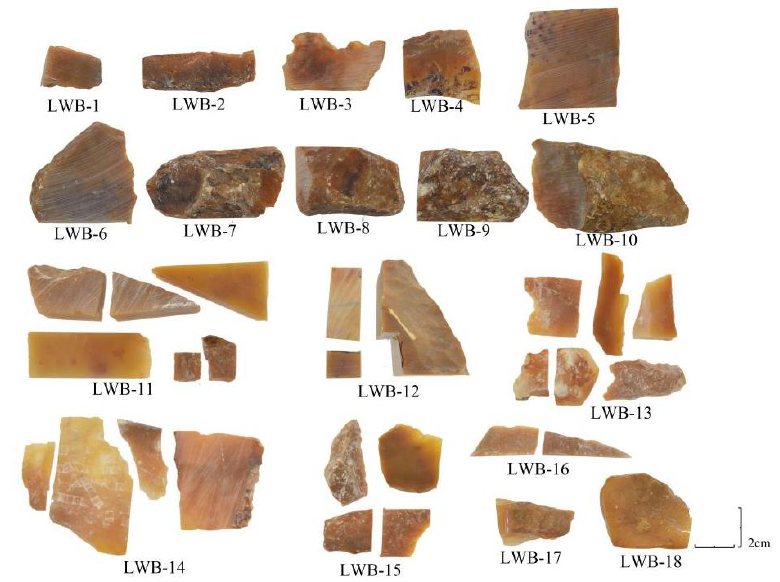
Figure 1. The studied samples of Laos seal stone (LWB-1~18).